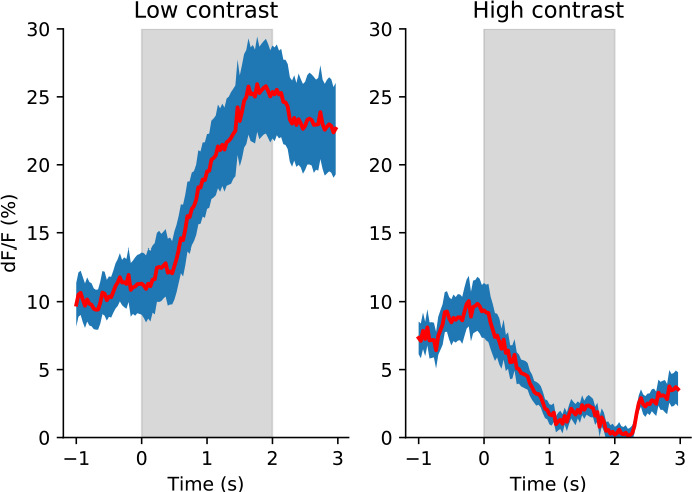
VIP neurons have evoked responses to low contrast gratings but response suppression to high contrast gratings.Average fluorescence responses of all VIP neurons to low (left) and high (right) contrast gratings are shown at the neuron’s preferred direction (n=63 neurons; mean ± SEM). Gray shading indicates the stimulus presentation window of 2 s; time is relative to stimulus onset.